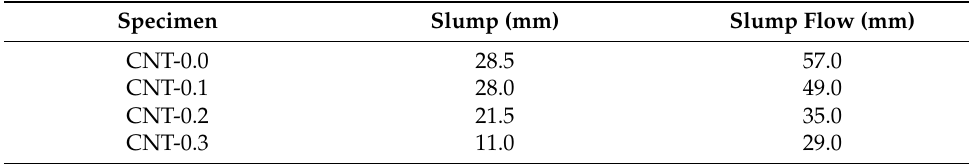
Table 5. Slump and slump